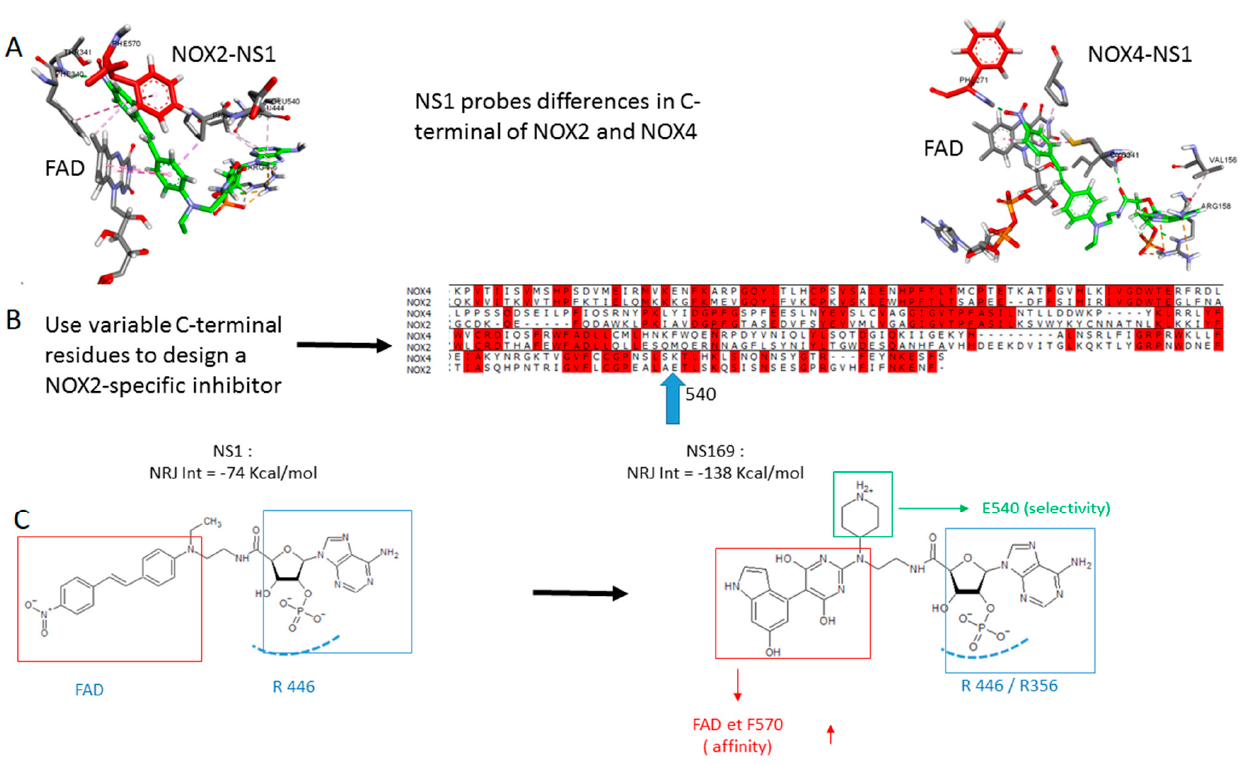
Figure 6. From a pan-NOX inhibitor NS1 to a NOX2-specific inhibitor NS169. ( A ) Comparison of the interactions of NS1 shown in green with NOX2 and NOX4; the C-terminal residue F570 in NOX2 is highlighted in red; ( B ) alignments of NOX2 and NOX4 C-terminal, identical residues are in red and variable residues in white; ( C ) Structures of NS1 and its NOX2-specific analog. The part of the compounds recognizing the conserved arginines/lysines of the protein is boxed in blue, the aromatic chromophore moieties recognizing FAD are boxed in red.